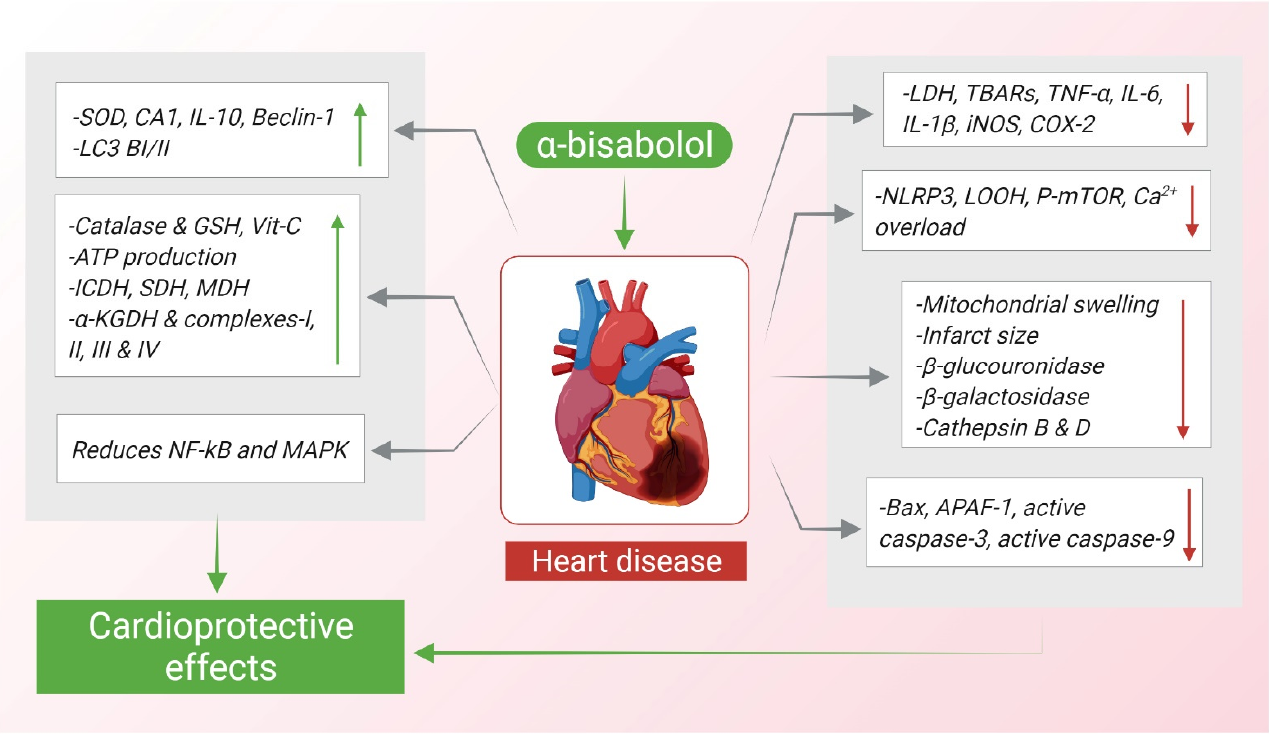
Figure 5. Schematic summary of cardioprotective actions of α -Bisabolol. ↑ ; increase, ↓ ; decrease.